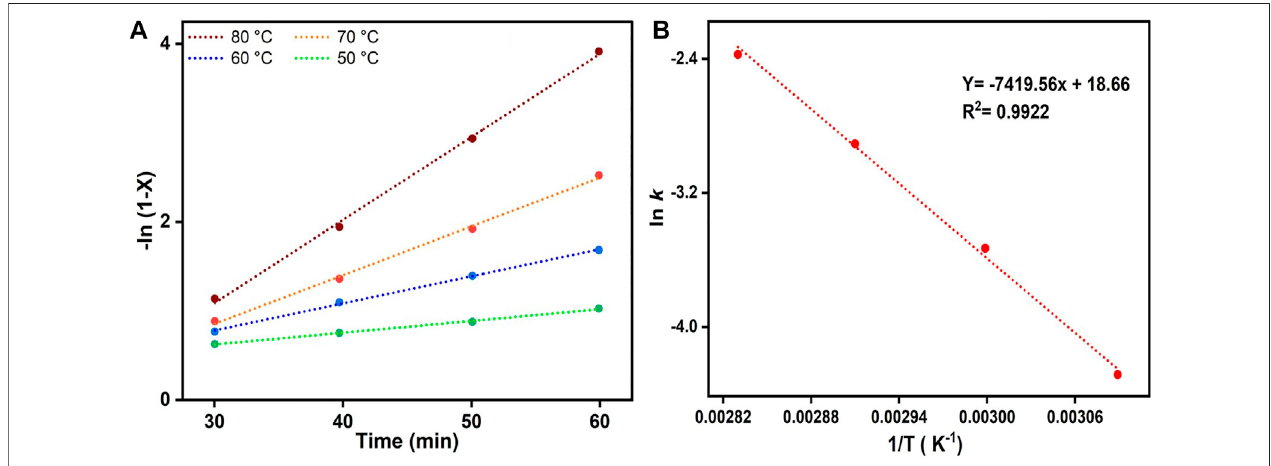
FIGURE 7 | (A) Graphical representation of – ln (1 – X) vs. t (where, X is conversion of OA) at different temperatures for the esteri fi cation of oleic acid with MeOH. (B) The corresponding Arrhenius plot of ln k vs. 1/T.